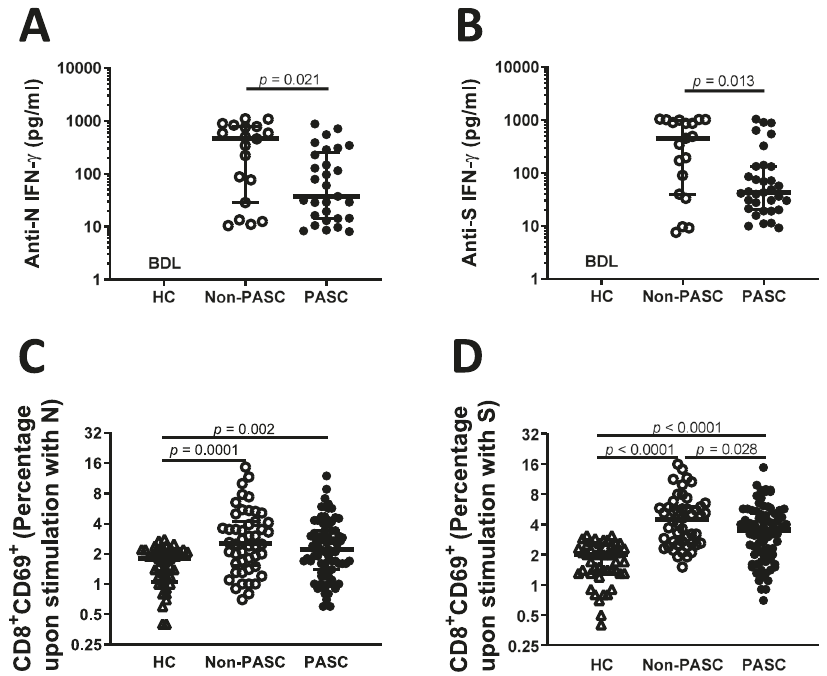
Fig. 2 | De fi cient memory response of CD8 + T cells of convalescent PASC patients. Peripheral blood mononuclear cells from non-PASC ( n =65) and PASC ( n =62) individuals were stimulated with N or S viral peptides. Interferon-gamma wasquanti fi edbyELISAuponstimulationwithN( A )andS( B )peptidesfor24h.All HC were tested, behaving below the detection limit of the technique. A Mann Whitney test was employed to compare the non-PASC and PASC groups. The